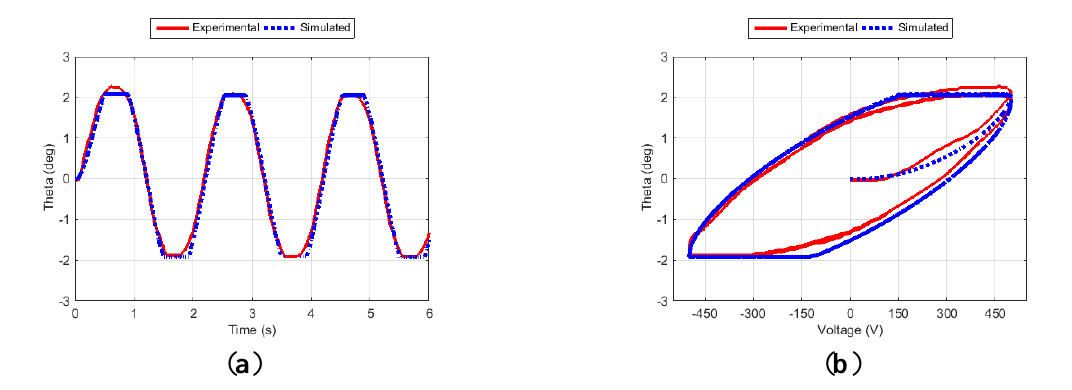
Figure 7. Fin angle ( a ) and hysteresis curve ( b ) for Case 5.